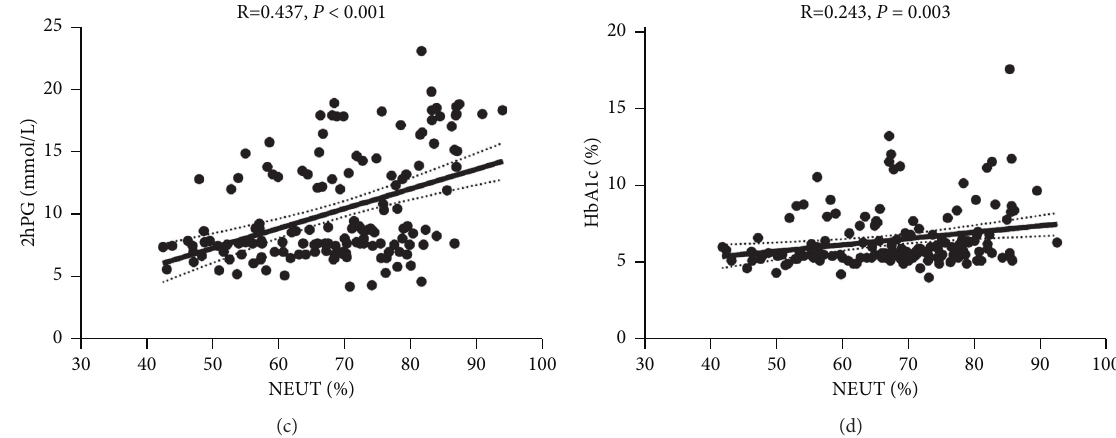
Figure 1: The percentage of neutrophils is associated with impaired glucose metabolism in patients with Cushing’s syndrome. (a) Neutrophilic granulocyte percentage (NEUT%) levels are much higher in DM patients than in non-DM. (b) Fasting glucose (FBG) levels are positively correlated with the percentage of neutrophilic granulocyte. (c) Levels of 2-hour postprandial blood glucose (2hPG) are positively correlated with the percentage of neutrophilic granulocyte. (d) Glycated hemoglobin (HbA1c) is positively correlated with the percentage of neutrophilic granulocyte.